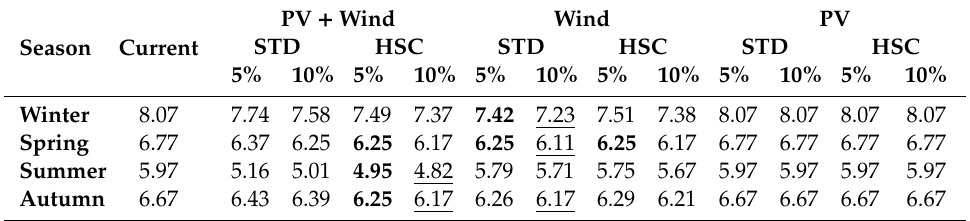
Table 2. Seasonal 98th net load percentile for each scenario in megawatts (bold numbers represent the minimum value for Surplus equal to 5%, while the underline highlights the minimum value for Max. Surplus equal to Max.